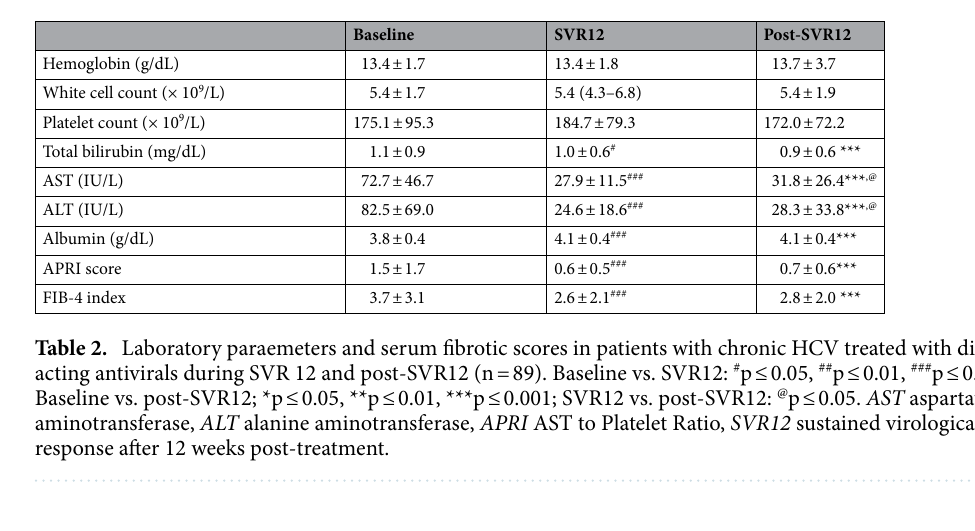
Figure 3. Diagnostic performance of TE, SWE, APRI and FIB-4 score using MRE as reference method.